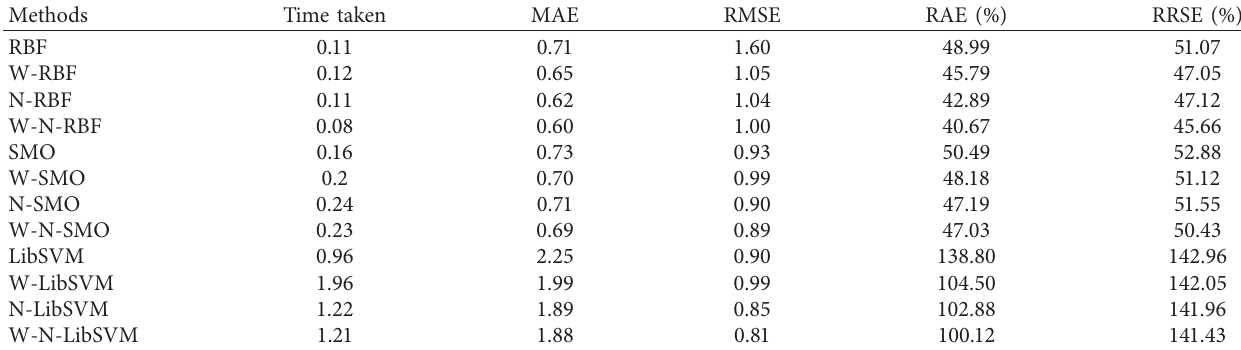
Table 5: Comparison of errors and time taken for evaporation, Delhi. Methods